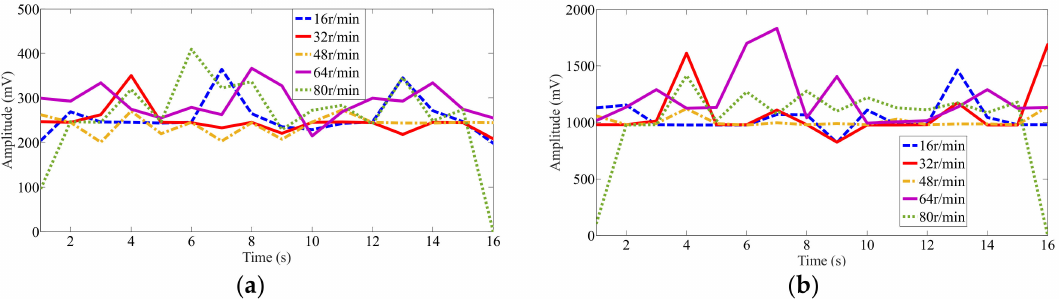
Figure 14. Mean and maximum recorded EMG signal values at left gluteus medius muscle locations for passive pedaling at different speeds: ( a ) Mean value at left side; ( b ) Maximum value at left side.